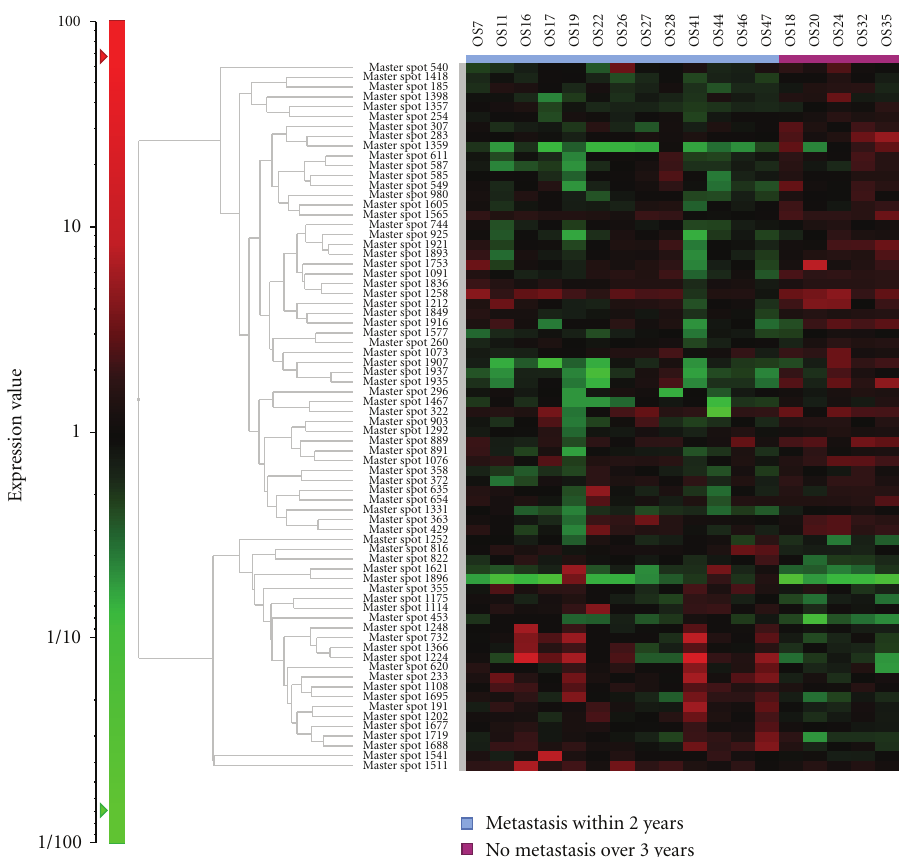
Figure 3: To identify proteins associated with the prognosis and malignant grade of osteosarcoma, we conducted a 2D-DIGE study using osteosarcoma biopsy samples. A hierarchical cluster analysis of 17 osteosarcoma showed that there were 72 protein spots that had di ff erent intensity out of a total of 1457 protein spots ( P < 0 . 05). The expected value of this study (from 1457 total protein spots and P < 0 . 05) was > 73 protein spots. Therefore, the study design also could not obtain a su ffi cient number of protein spots which had statistically significant di ff